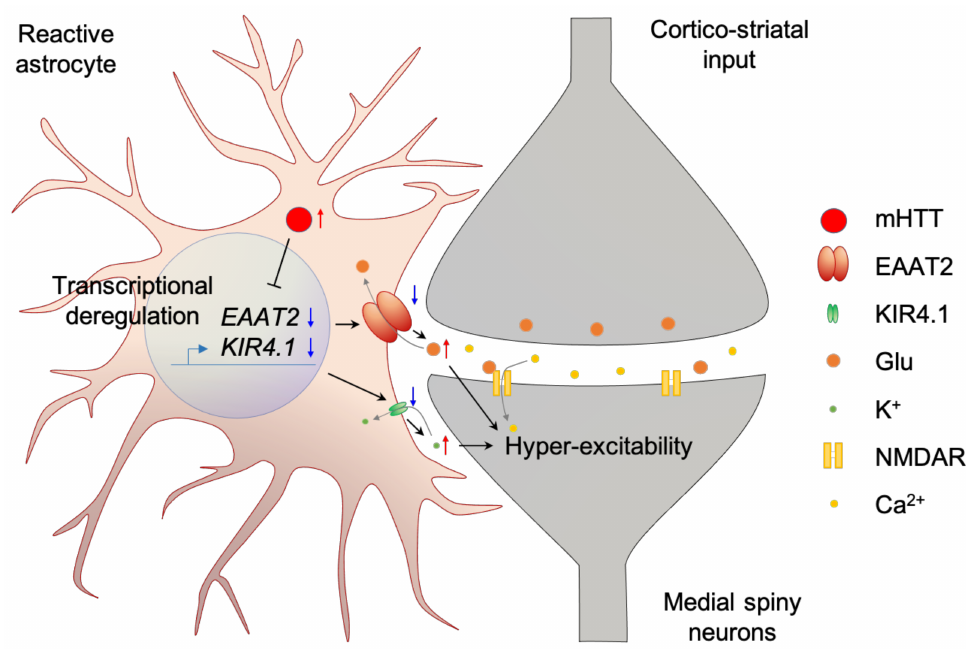
Figure 1. Dysfunction of cortico-striatal tripartite synapse in HD. mHTT aggregation deregulates transcription of EAAT2 and Kir4.1 in astrocytes. Deregulation of EAAT2 leads to low expression level of astrocyte glutamate transporter and impairment of the glutamate uptake by astrocytes in the tripar- tite synapse. As a result, excess glutamate in synapse induces hyper-excitability of the post-synaptic neuron (medial spiny neuron in cortico-striatal synapse). Deregulation of Kir4.1 leads to impaired potassium buffering of astrocytes. As a result, elevated potassium ion concentration increases the membrane potential of neurons, where high membrane potential induces hyper-excitability. Prolonged hyper-excitability is rendered as cellular toxicity. Table 1. Non-cell autonomous cell death pathway in HD related to